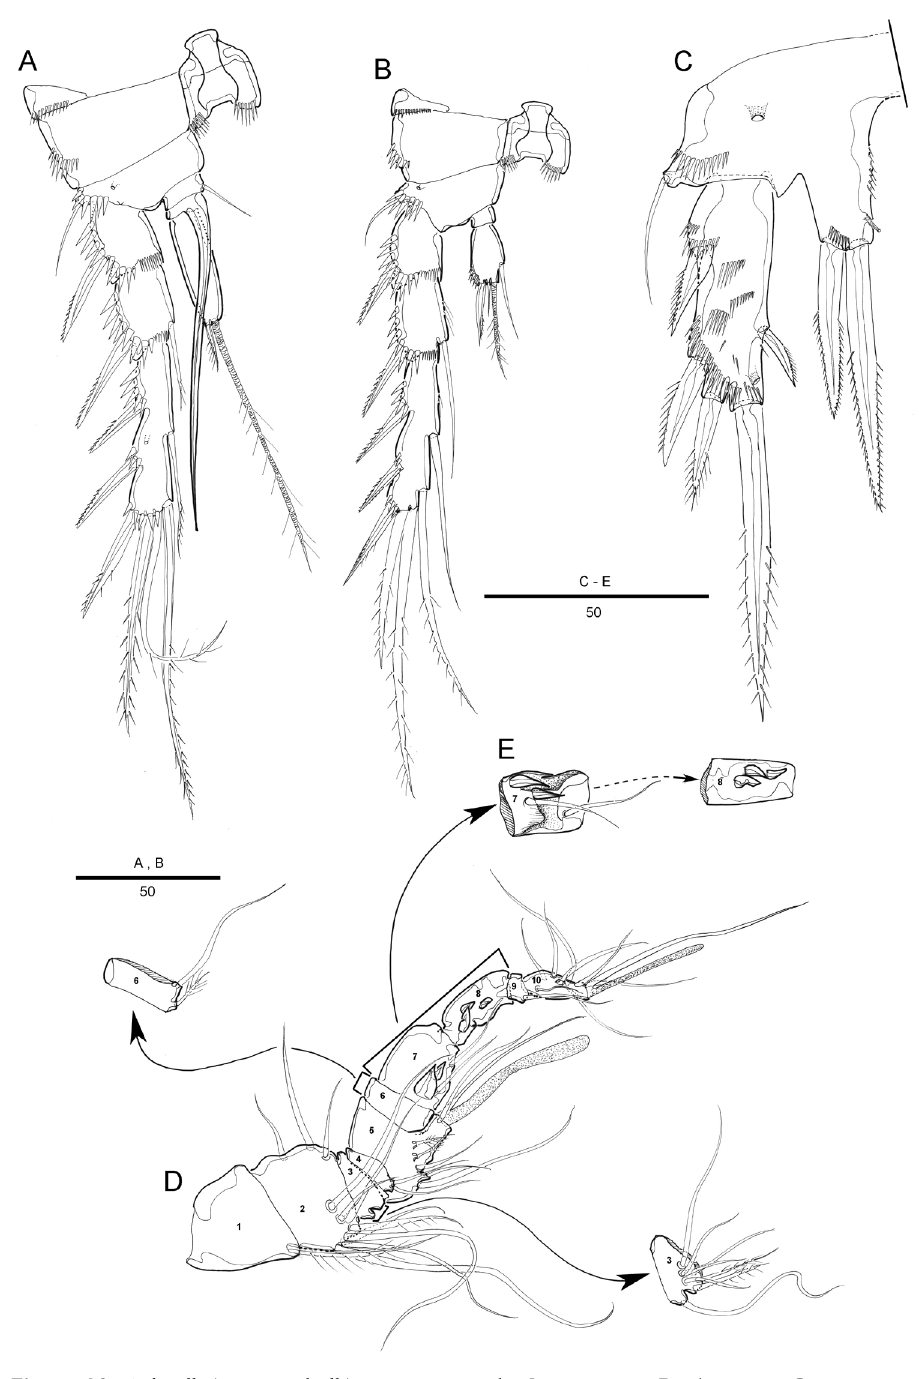
Figure 10. Attheyella ( Neomrazekiella ) tessiae sp. n. male: A P3, anterior B P4, anterior C P5, anterior D antennule E seventh and eighth segments of antennule, other